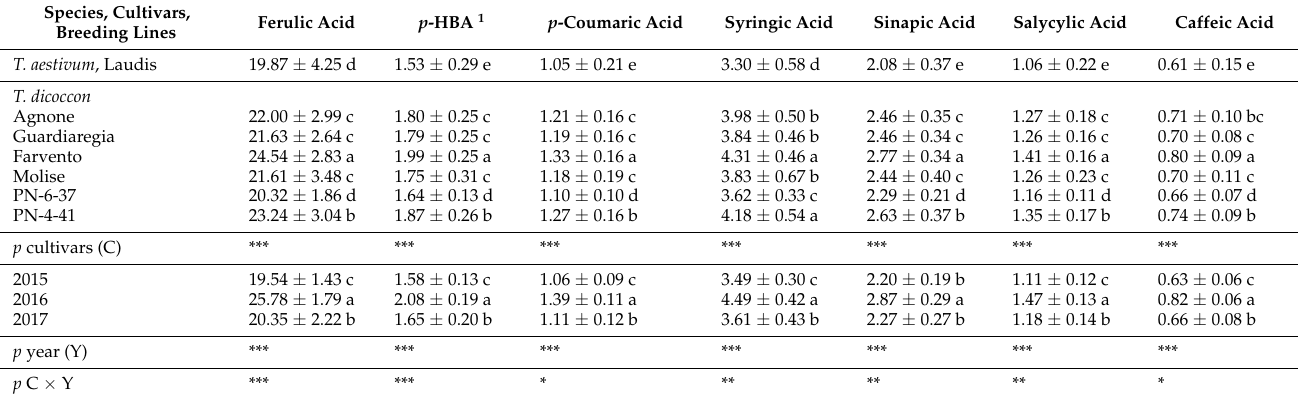
Table 4. Effect of wheat cultivars and growing years on free individual phenolic acids concentration ( µ g g − 1 DM) in whole-grain